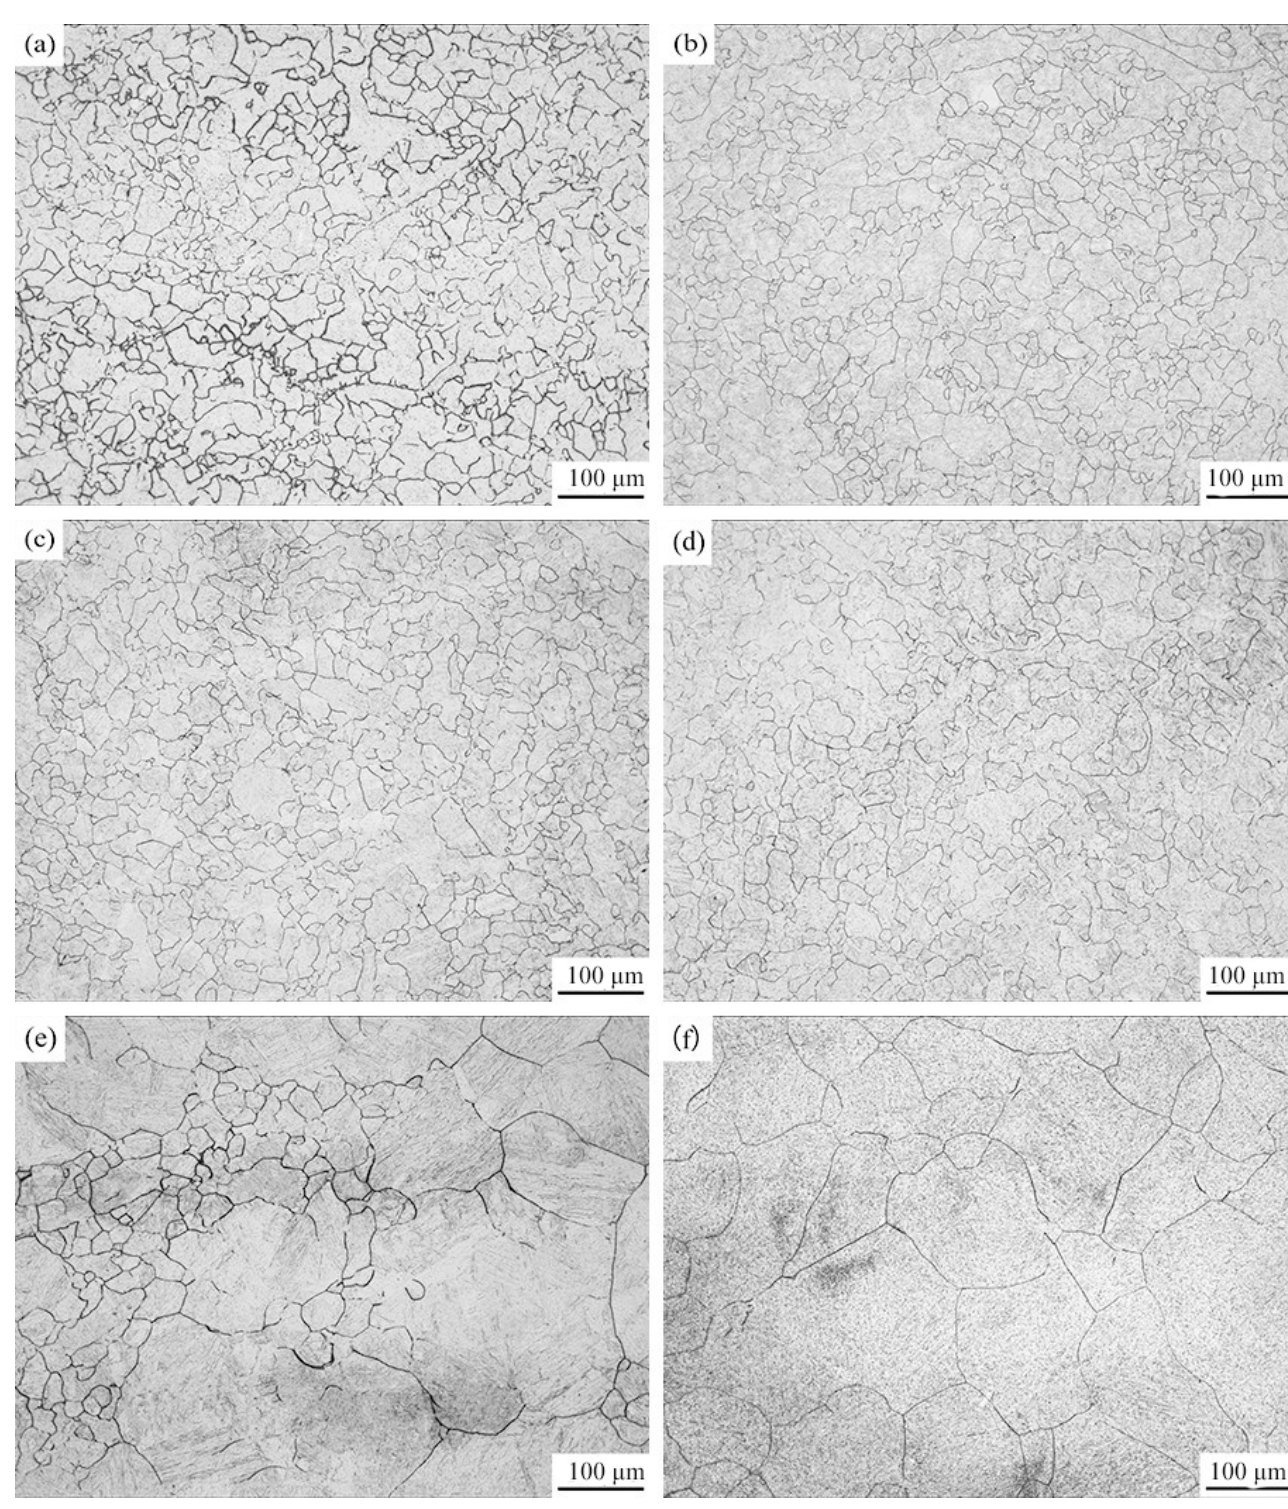
Figure 6. Austenite grain morphology of the hot-rolled specimens at different heating temperatures ( a ) 850 °C; ( b ) 870 °C; ( c ) 920 °C; ( d ) 970 °C; ( e ) 1020 °C; ( f ) 1070 °C .